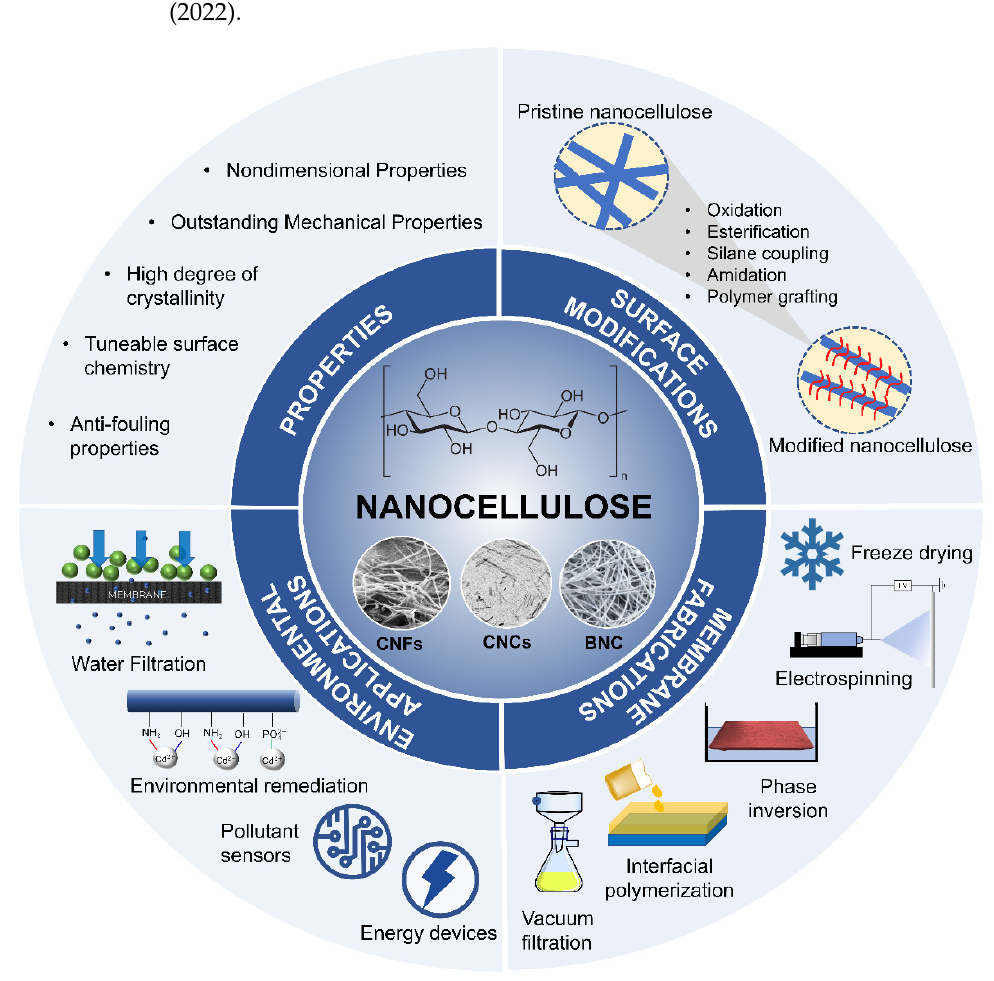
Figure 2. Overview of the highlights of the present review: desirable properties of nanocellulose, surface modification strategies, approaches for nanocellulose ‐ based membrane fabrication and their surface modification strategies, approaches for nanocellulose-based membrane fabrication and their environmental applications. environmental